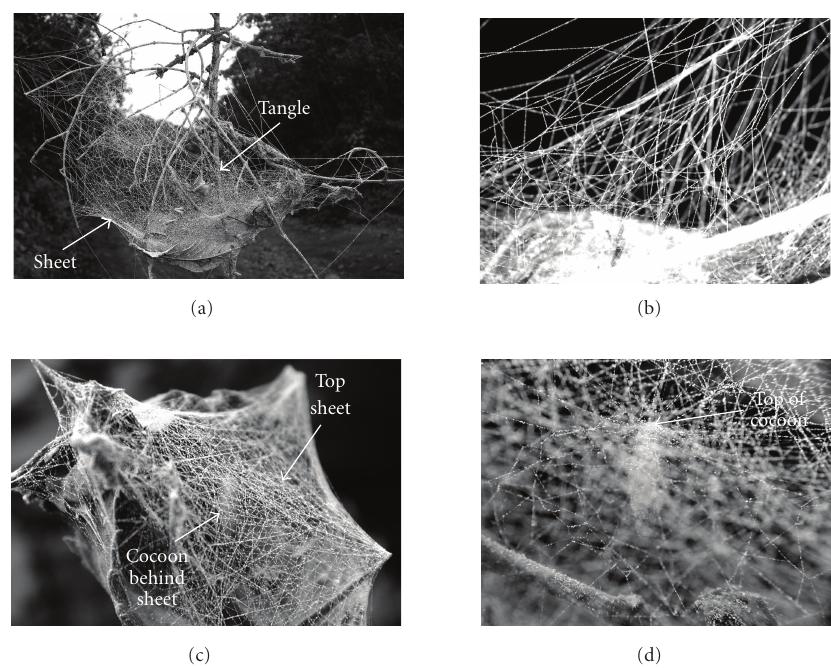
Figure 1: Lateral views of an entire typical web of a nonparasitized mature female A. octavius (a) and a closeup view of the tangle (b). Lateral views of a cocoon web of A . nr. studiosus with a sheet enclosing the entire web (c), and of the central platform in the tangle of this web to which the upper portion of a wasp cocoon is attached